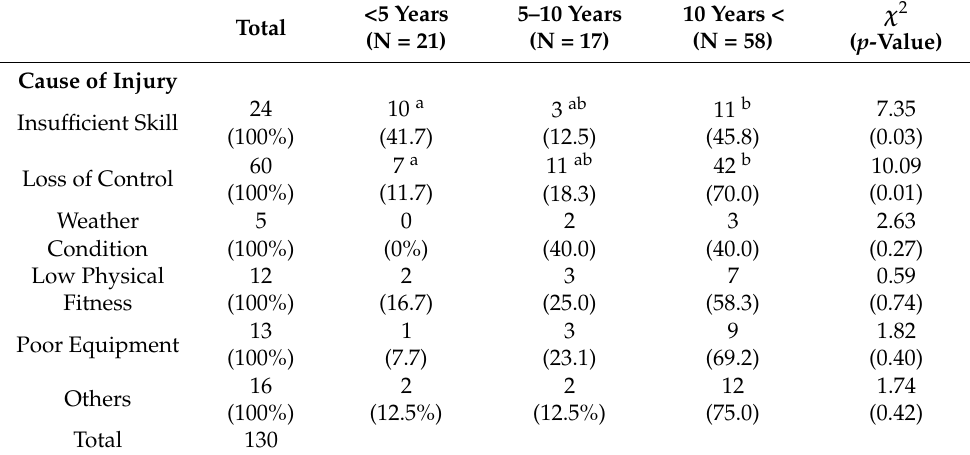
Table 5. The distribution of the cause of injury by the level of ski